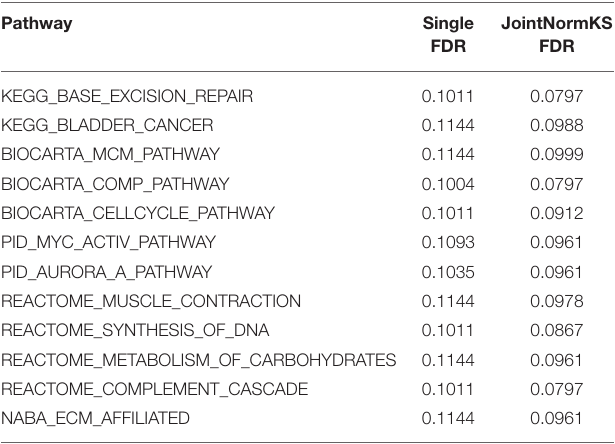
TABLE 2 | Pathways exclusively identified by JointNormKS in lung adenocarcinoma data set.